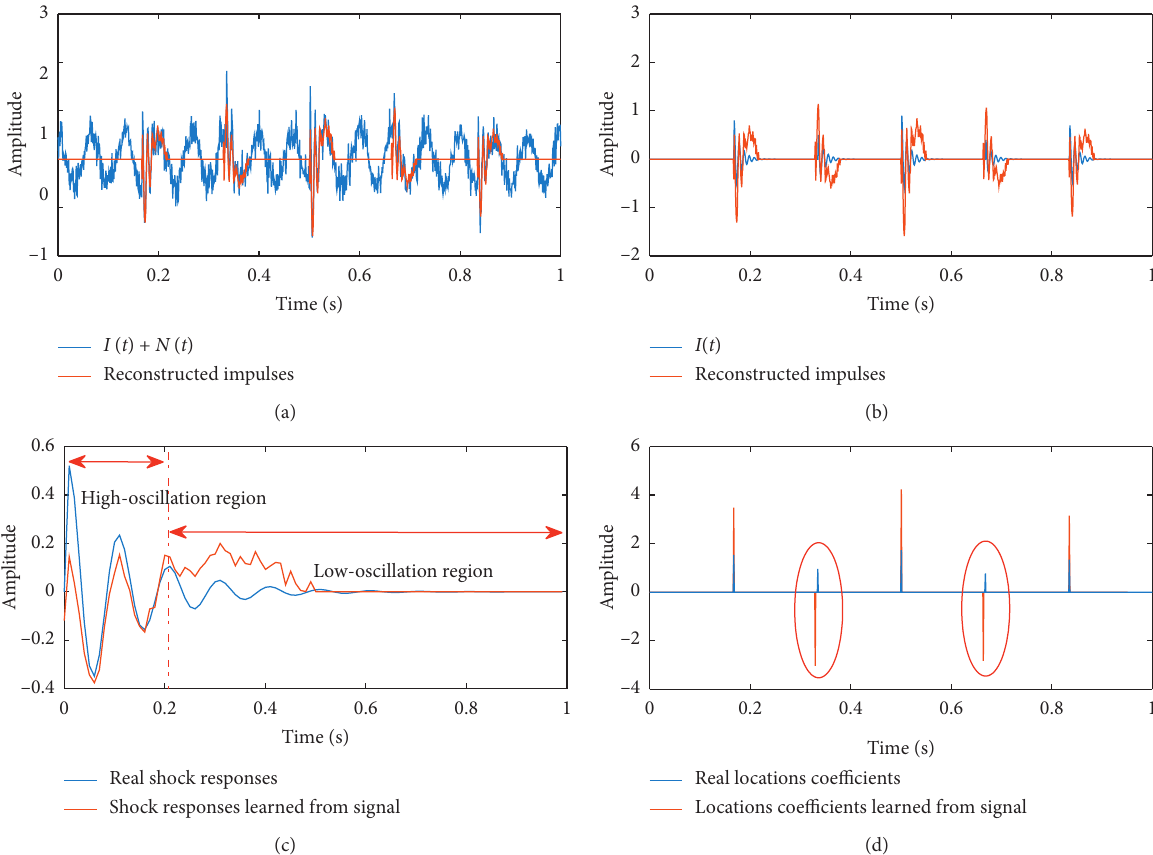
Figure 4: The result of UC-DLA processing signal s ( t ) . (a) Impulses obtained by convolution sparse reconstruction; (b) comparison of reconstructed impulses and real impulses; (c) shock responses learned from signal; and (d) location coefficients obtained from